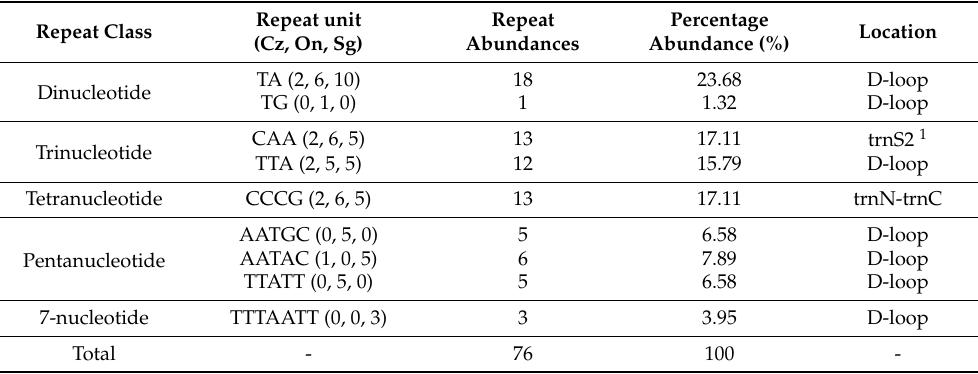
Table 1. Tandem repeats of the Nile tilapiine mitogenomes, including repeat class, repeat unit, repeat abundances, percentage abundance, and location. The numbers in parentheses in the repeated unit represent this unit in each species C. zillii , O. niloticus , and S. galilaeus , respectively. Repeat unit Repeat Percentage Repeat Class Location (Cz, On, Sg) Abundances Abundance (%) TA (2, 6, 10) 18 23.68 D-loop Dinucleotide TG (0, 1, 0) 1 1.32 D-loop CAA (2, 6, 5) 13 17.11 trnS2 1 Trinucleotide TTA (2, 5, 5) 12 15.79 D-loop Tetranucleotide CCCG (2, 6, 5) 13 17.11 trnN-trnC AATGC (0, 5, 0) 5 6.58 Pentanucleotide 7-nucleotide TTTAATT (0, 0, 3) 3 3.95 D-loop Total - 76 100